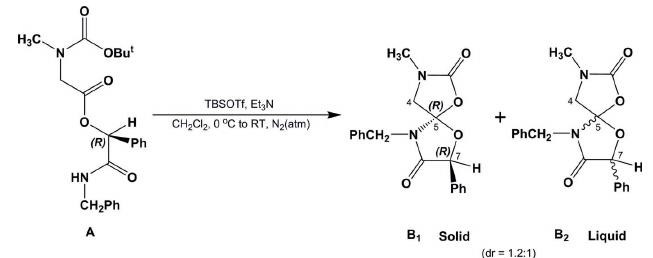
Figure 1 Reaction scheme for the synthesis of 9-benzyl-3-methyl-7-phenyl-1,6-